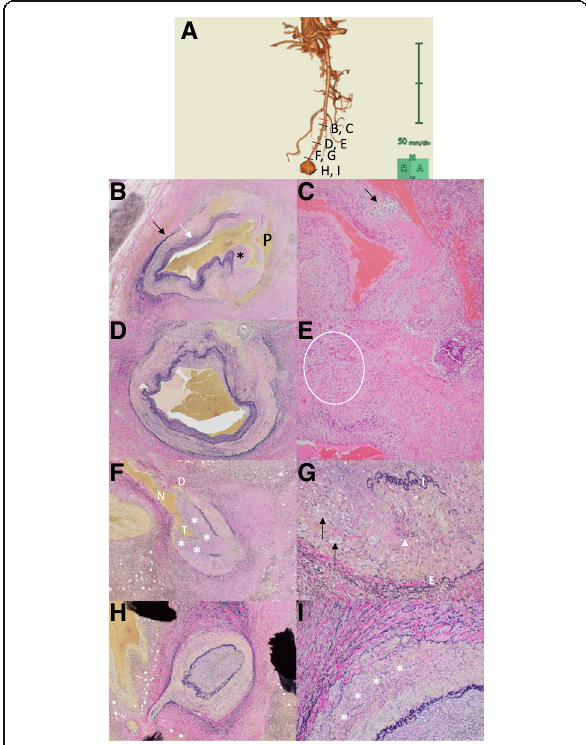
Fig. 3 Histopathologic findings of resected specimen. a CT angiograph of the SMA on Day 6 indicating the origin of each section; letters A through I correspond to Fig. 3a through i (black lines). Red line indicates the position of the SMA resection stump. b Low-power view (LPV) (×100) with Elastica van Gieson (EVG) staining of the SMA adjacent to the proximal resection stump. Internal (white arrow) and external (black arrow) elastic laminae as well as arterial media have partially disappeared and there is prominent intimal proliferation (asterisk). On CT angiography, this region showed only mild vasodilatation but an entry point of latent dissection was seen. “ P ” indicates pseudolumen filled mainly with fibrin. c High-power view (HPV) (×400) with hematoxylin and eosin (HE) staining shows vacuolization (black arrow) and marked decrease in the number of vascular smooth muscle cells (SMCs). d LPV (×100) with EVG staining of the area slightly distal to the lesion shows latent dissection with preserved internal elastic lamina and eccentric intimal proliferation. e HPV (×400) with HE staining also shows a vacuolization-rich area (ellipse) in the arterial media and disturbed arrangement of medial SMCs. f LPV (×100) of the SMA with EVG staining of the area adjacent to the pseudoaneurysm neck (N) showing remarkable stenosis of the true lumen (T) due to intimal proliferation (asterisks). A small dissection (D) is also observed, but wall rupture and resultant aneurysm formation are predominant. Arterial wall adjacent to aneurysm neck lacks medial SMCs. g HPV (×400) with EVG staining of the SMA adjacent to the neck of the pseudoaneurysm. Arterial media between internal (I) and external (E) elastic laminae shows focal vacuolization (black arrows) and degeneration of vascular SMCs (white arrow). h LPV (×100) with EVG staining of the SMA distal to the pseudoaneurysm. Both internal and elastic laminae are preserved and intimal proliferation is unremarkable. Arterial lumen is occluded with thrombus. i HPV (× 400) of the distal SMA with EVG staining. There is not a great deal of vacuolization, but degeneration and disarrangement of the outer media (asterisks) are